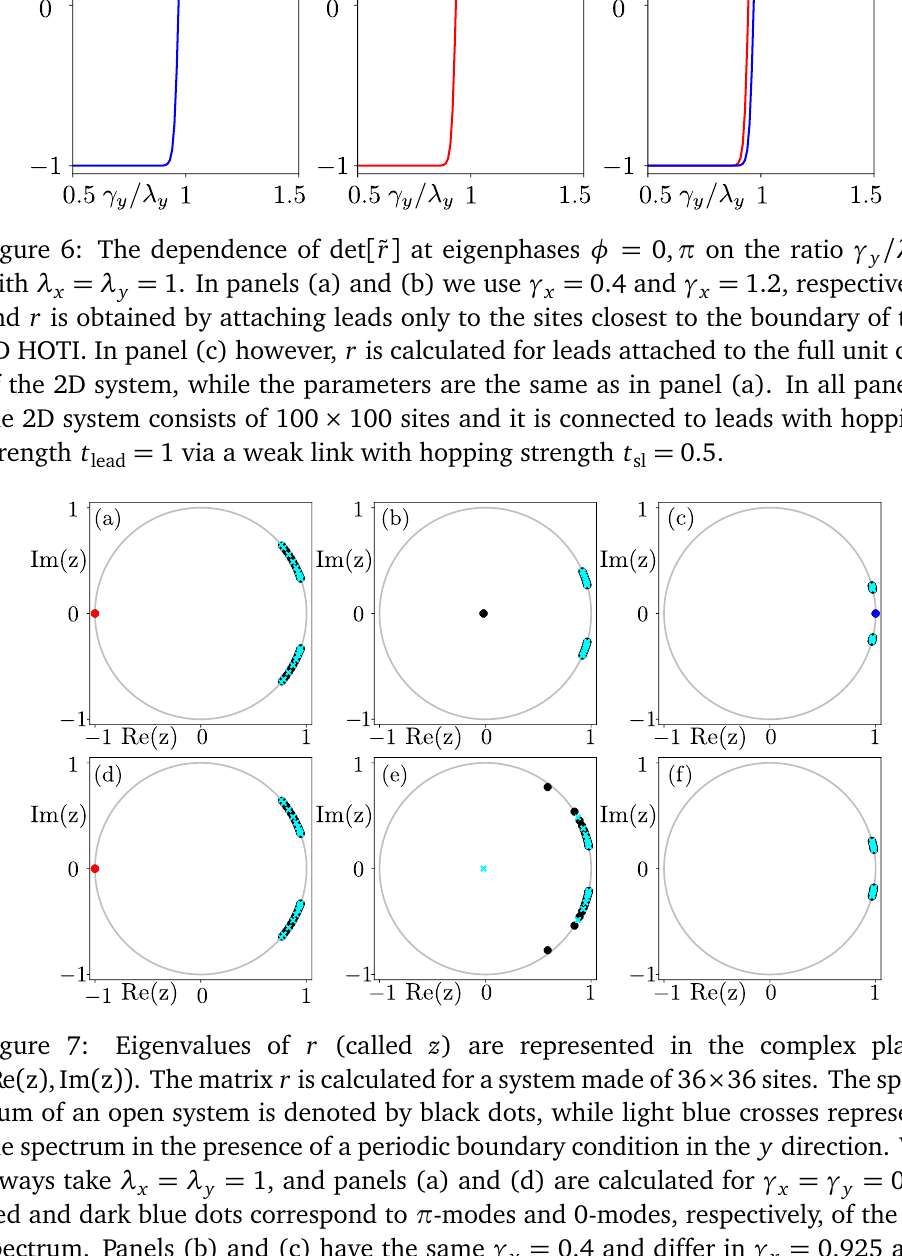
= γ = 0.4. x y = 0.4 and differ in γ = 0.925 and y x = 0.925 and γ = 1, x y = 1 and t = 0.5 for all lead sl